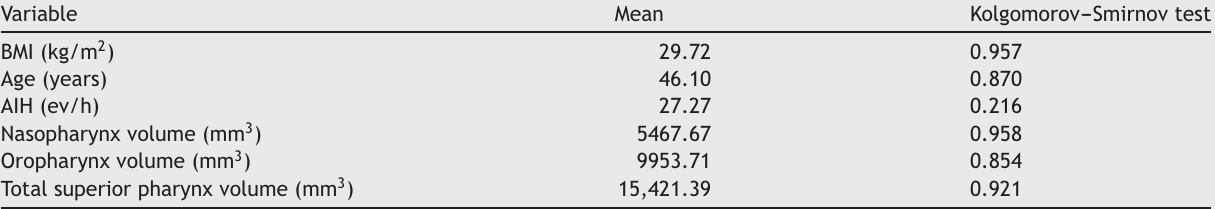
Description and normality test of continuous variables.